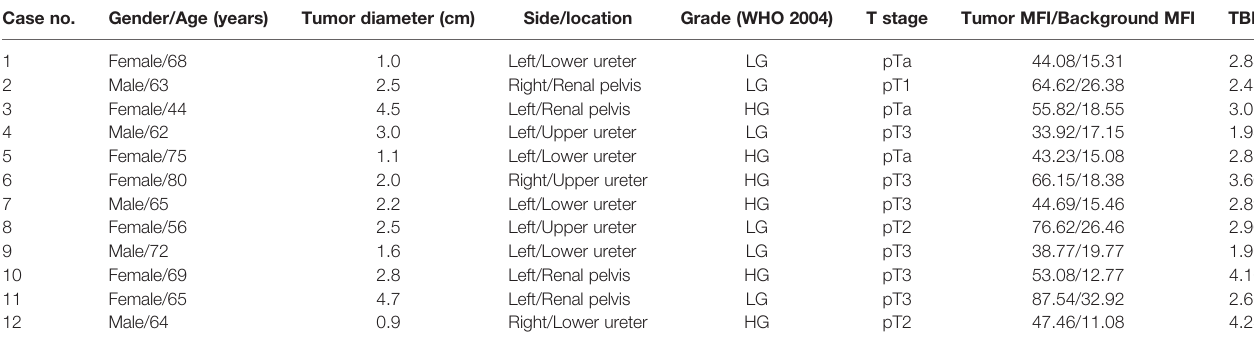
TABLE 2 | Patient ’ s demographic data, histopathological diagnosis, and molecular imaging results with anti-CD47-Alexa Fluor 790 NIR molecular imaging. Case